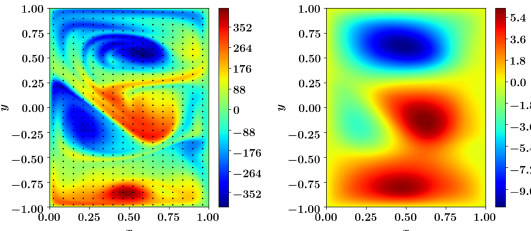
Figure 13. A Typical vorticity (left) and streamfunction (right) field for the single-layer QG model. The dots shows the locations of observations.